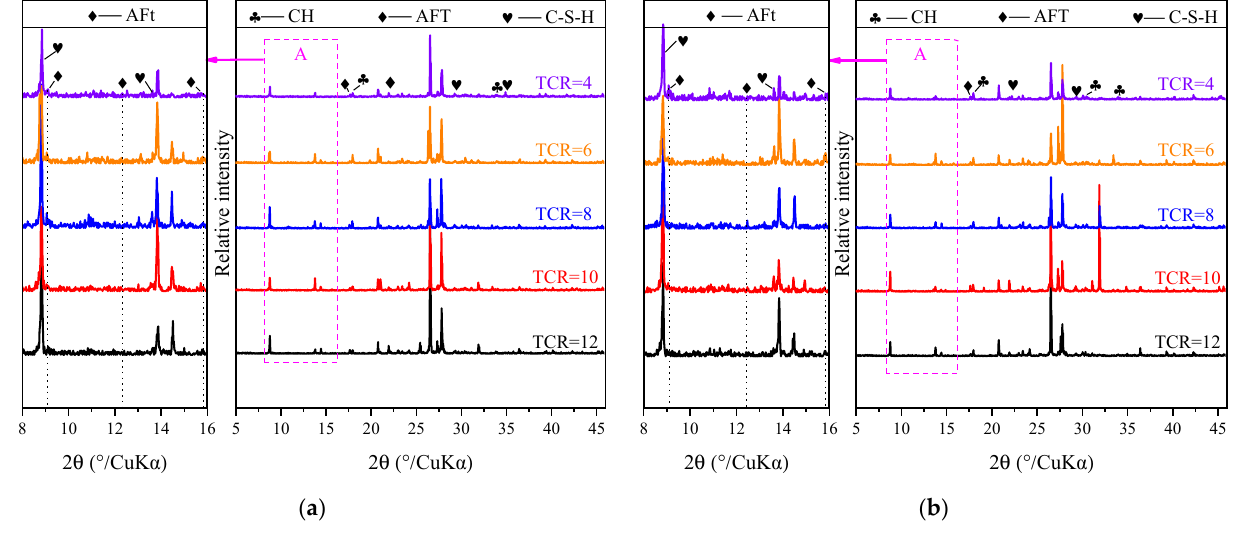
Figure 9. XRD patterns of CSTB in 3d ( a ) and 7d ( b ) under SC = 72%.